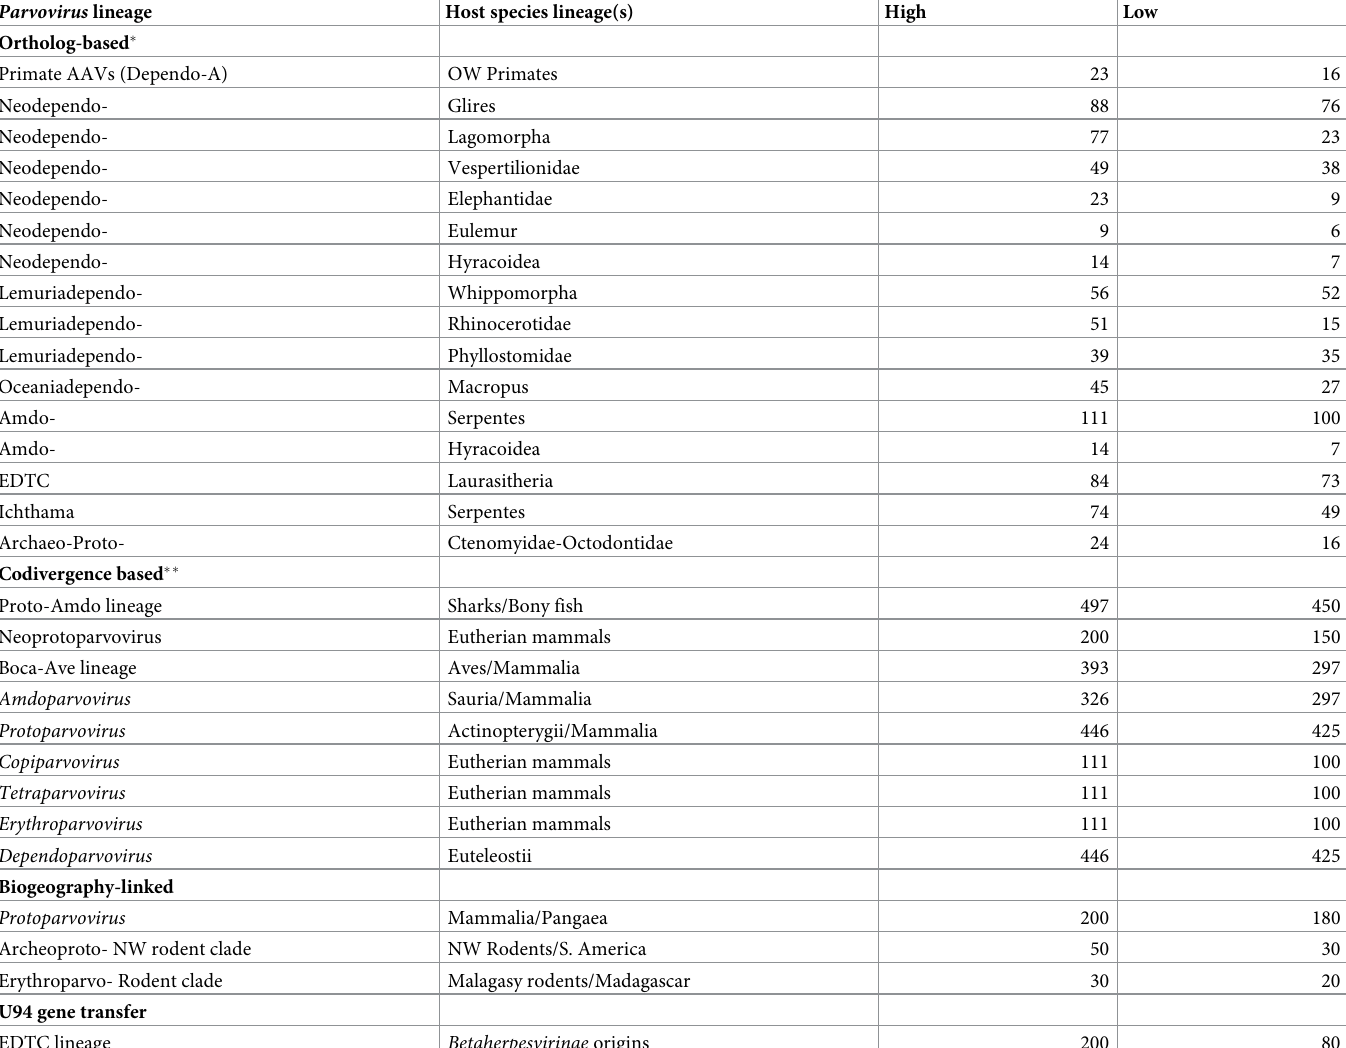
Table 3. Dates and age estimates used to calibrate parvovirus